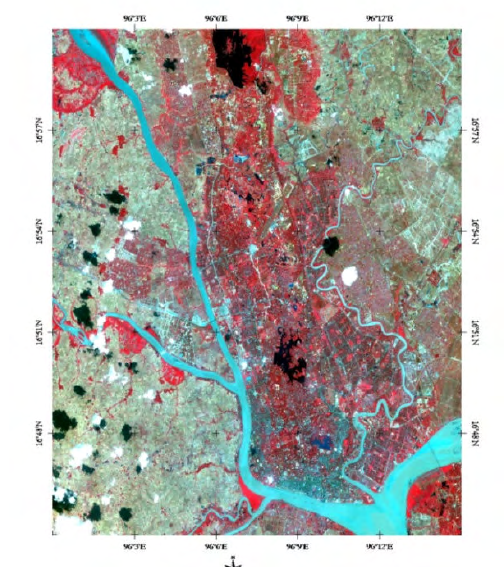
Figure 4. ADEOS/AVNIR 432 FCC Color Composite